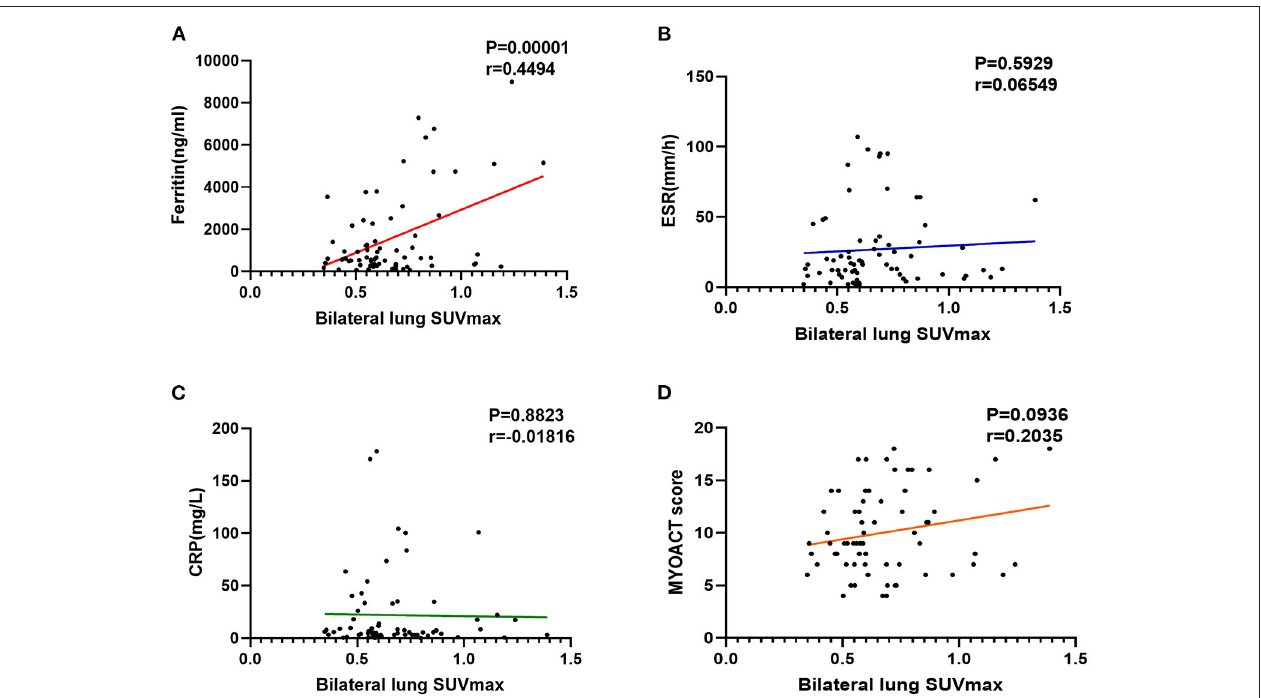
FIGURE 4 | Evaluation of abnormal lung FDG uptake in the patients with anti-MDA5 + DM. (A) Correlation between ferritin and bilateral lung SUVmax. (B) Correlation between ESR and bilateral lung SUVmax. (C) Correlation between CRP and bilateral lung SUVmax. (D) Correlation between MYOACT score and bilateral lung SUVmax. FDG, 18 F-fluorodeoxyglucose; MDA5, melanoma differentiation associated protein 5; DM, dermatomyositis; SUVmax, maximum standardized uptake value; ESR, Erythrocyte sedimentation rate; CRP, C-reactive protein; MYOACT, Myositis Disease Activity Assessment Visual Analog